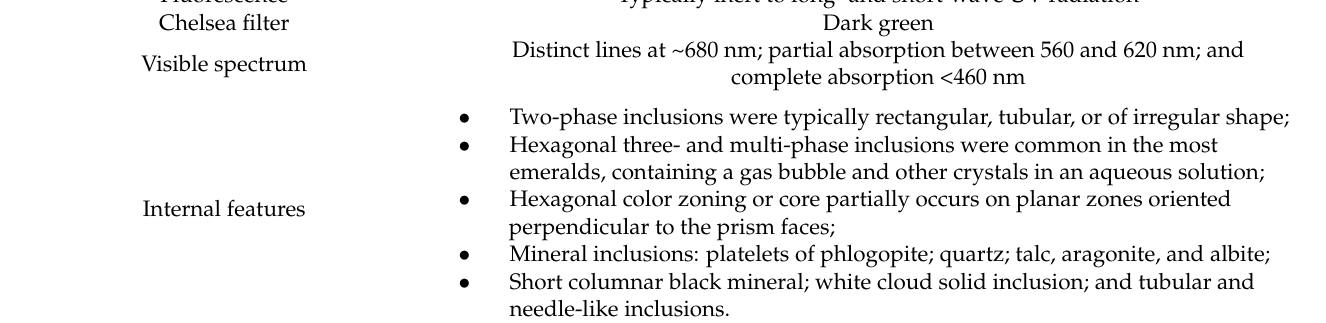
Table 1. Gemological properties of emeralds from India.